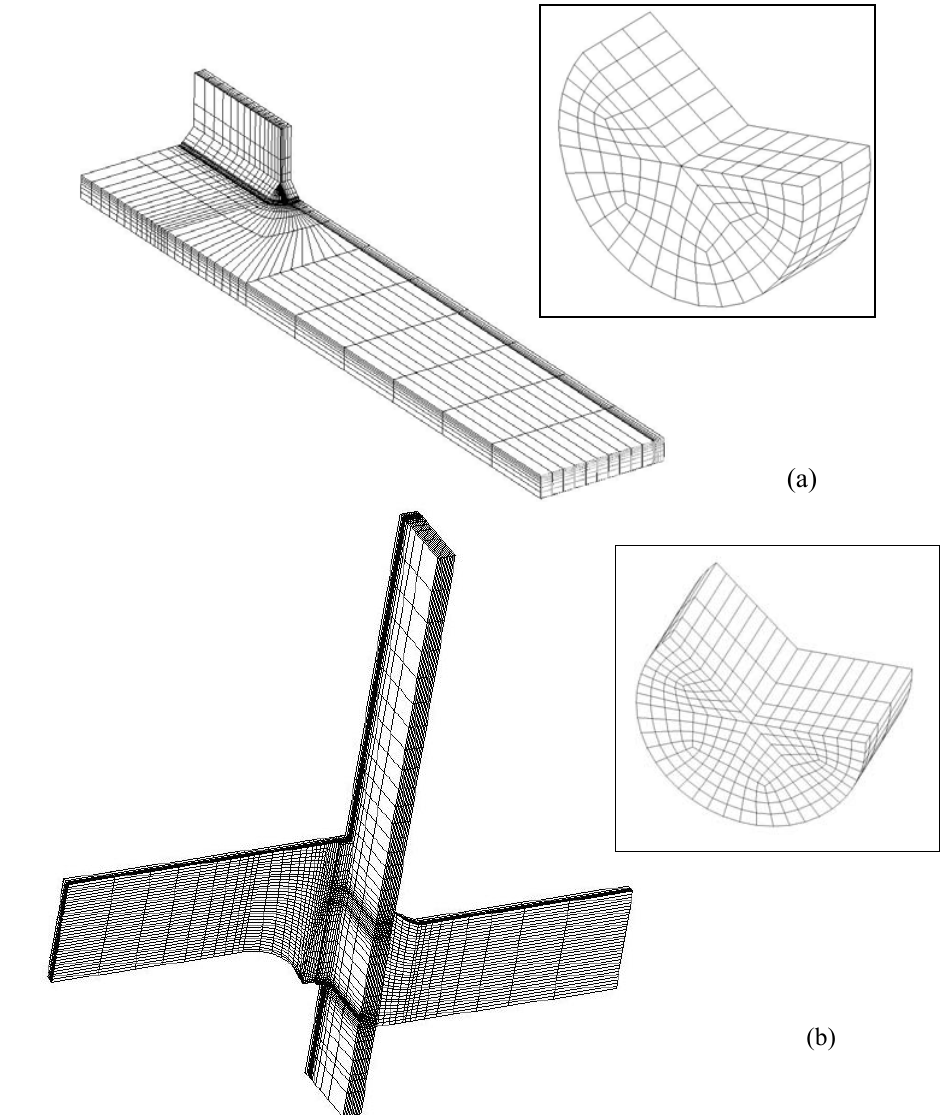
Figura 6. Esempio di modellazione del giunto ad irrigidimento longitudinale già analizzato da Maddox [11] (a) e del giunto cru- ciforme già analizzato da Fricke e Doerk [13] (b); modelli complessivi e particolari relativi alla modellazione del volume struttu-